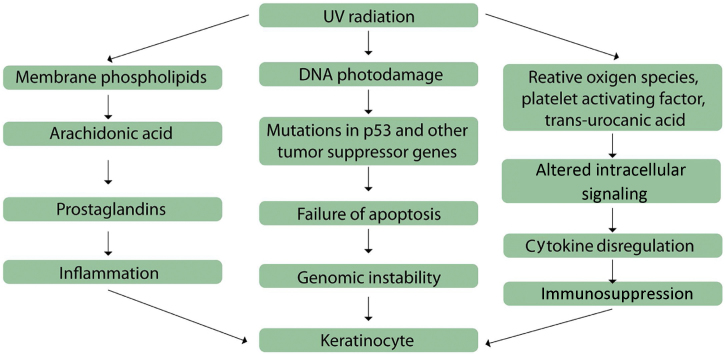
Mechanisms involved in actinic keratoses pathogenesis. Adapted from: Berman B, Cockerell CJ. Pathobiology of actinic keratosis: ultraviolet-dependent keratinocyte proliferation. Berman B, et al. (2013).8